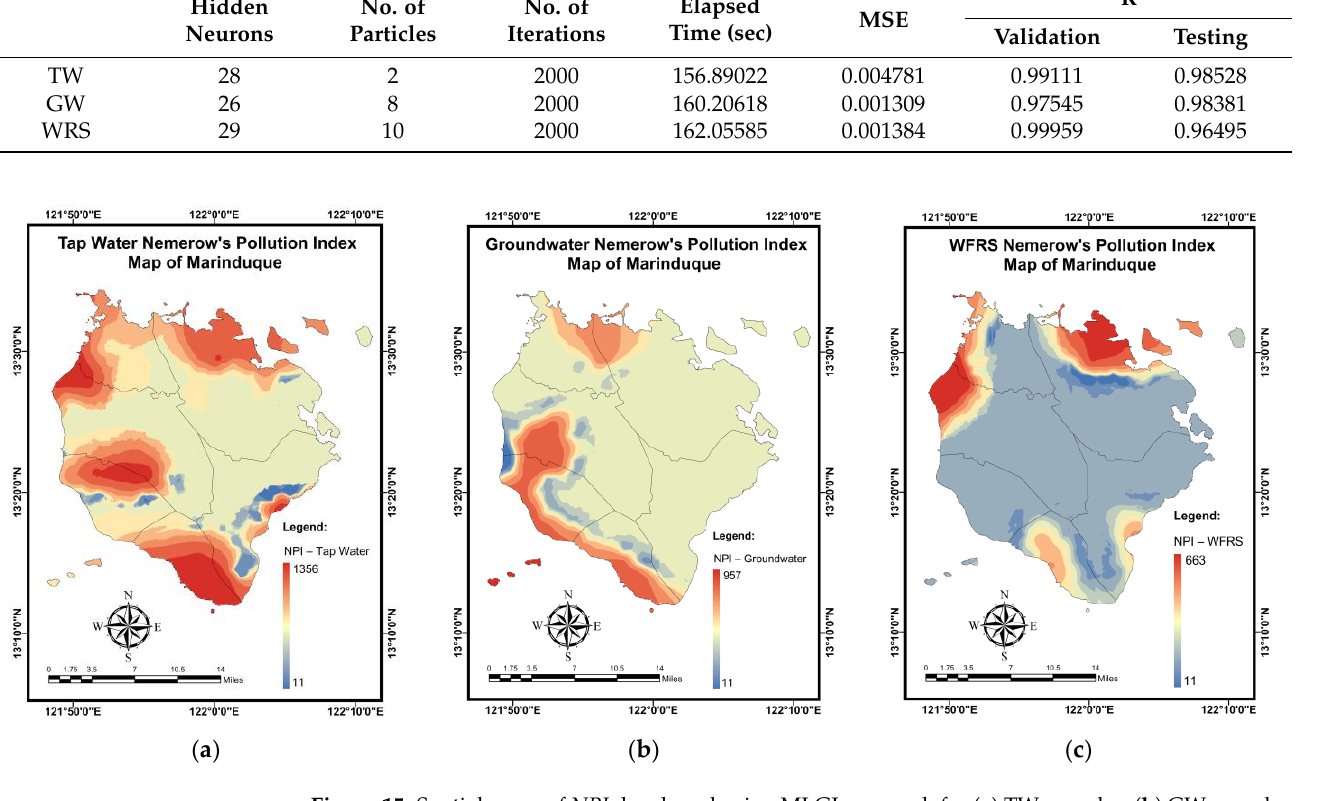
Figure 15. Spatial maps of NPI developed using MLGI approach for ( a ) TW samples, ( b ) GW samples, and ( c ) WRS samples.